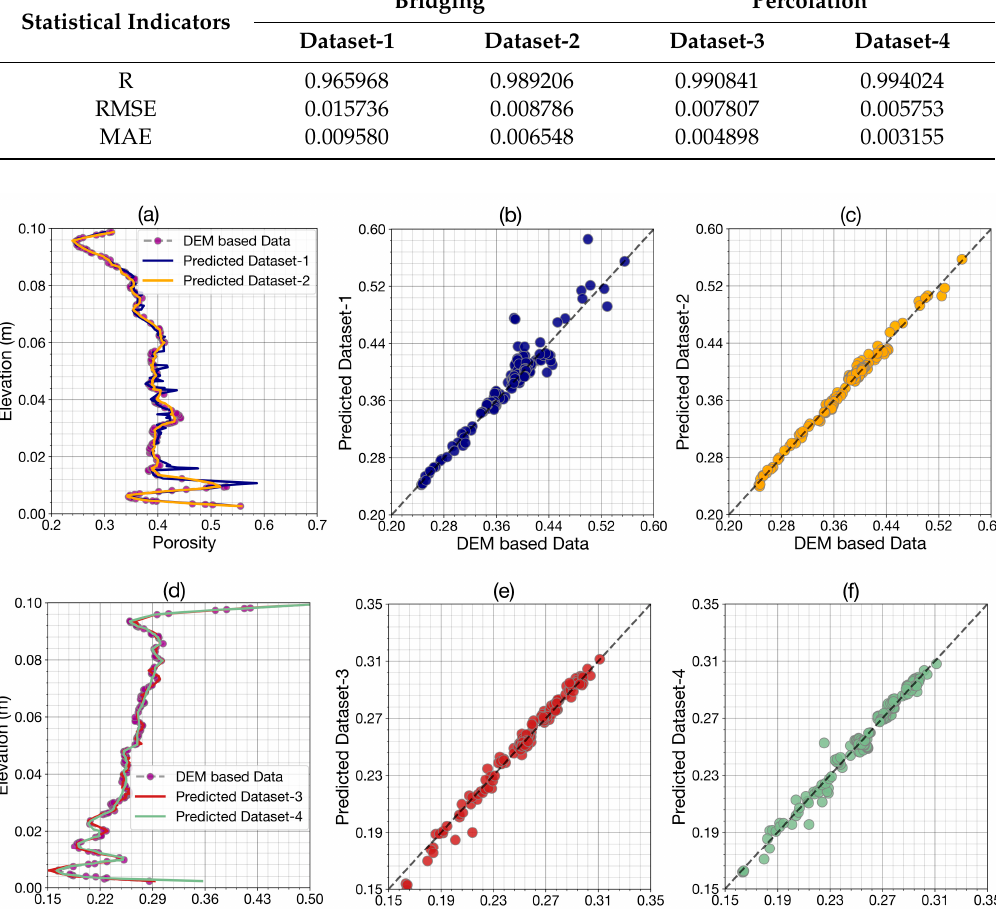
Figure 11. FNN predicted porosity along the depth (z-direction) ( a ) Datasets 1 and 2, ( d ) Datasets 3 and 4, and scatter plot ( b ) Dataset-1, ( c ) Dataset-2, ( e ) Dataset-3, and ( f ) Dataset-4.